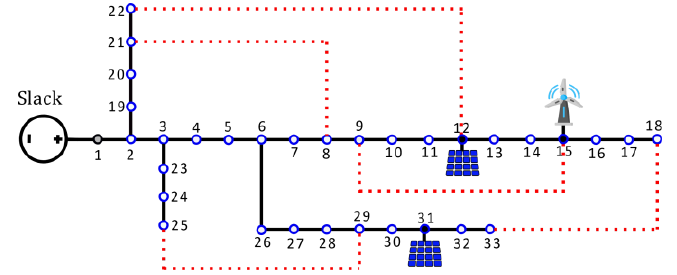
Figure 2. Modified 33-node LVDC test feeder [3,4].